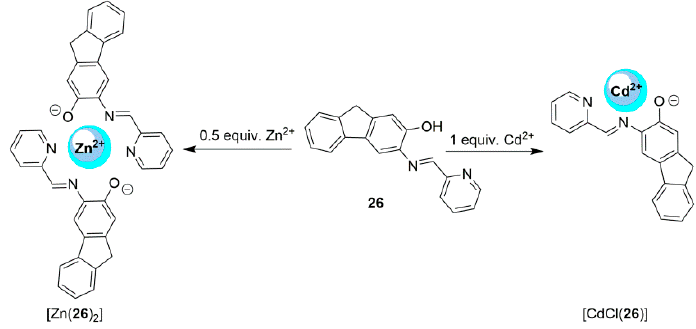
Figure 10. Logic schemes prepared from the binary inputs/outputs in the Truth tables [180]. Table 3. Truth table highlighting the binary inputs and the corresponding digital output [180].